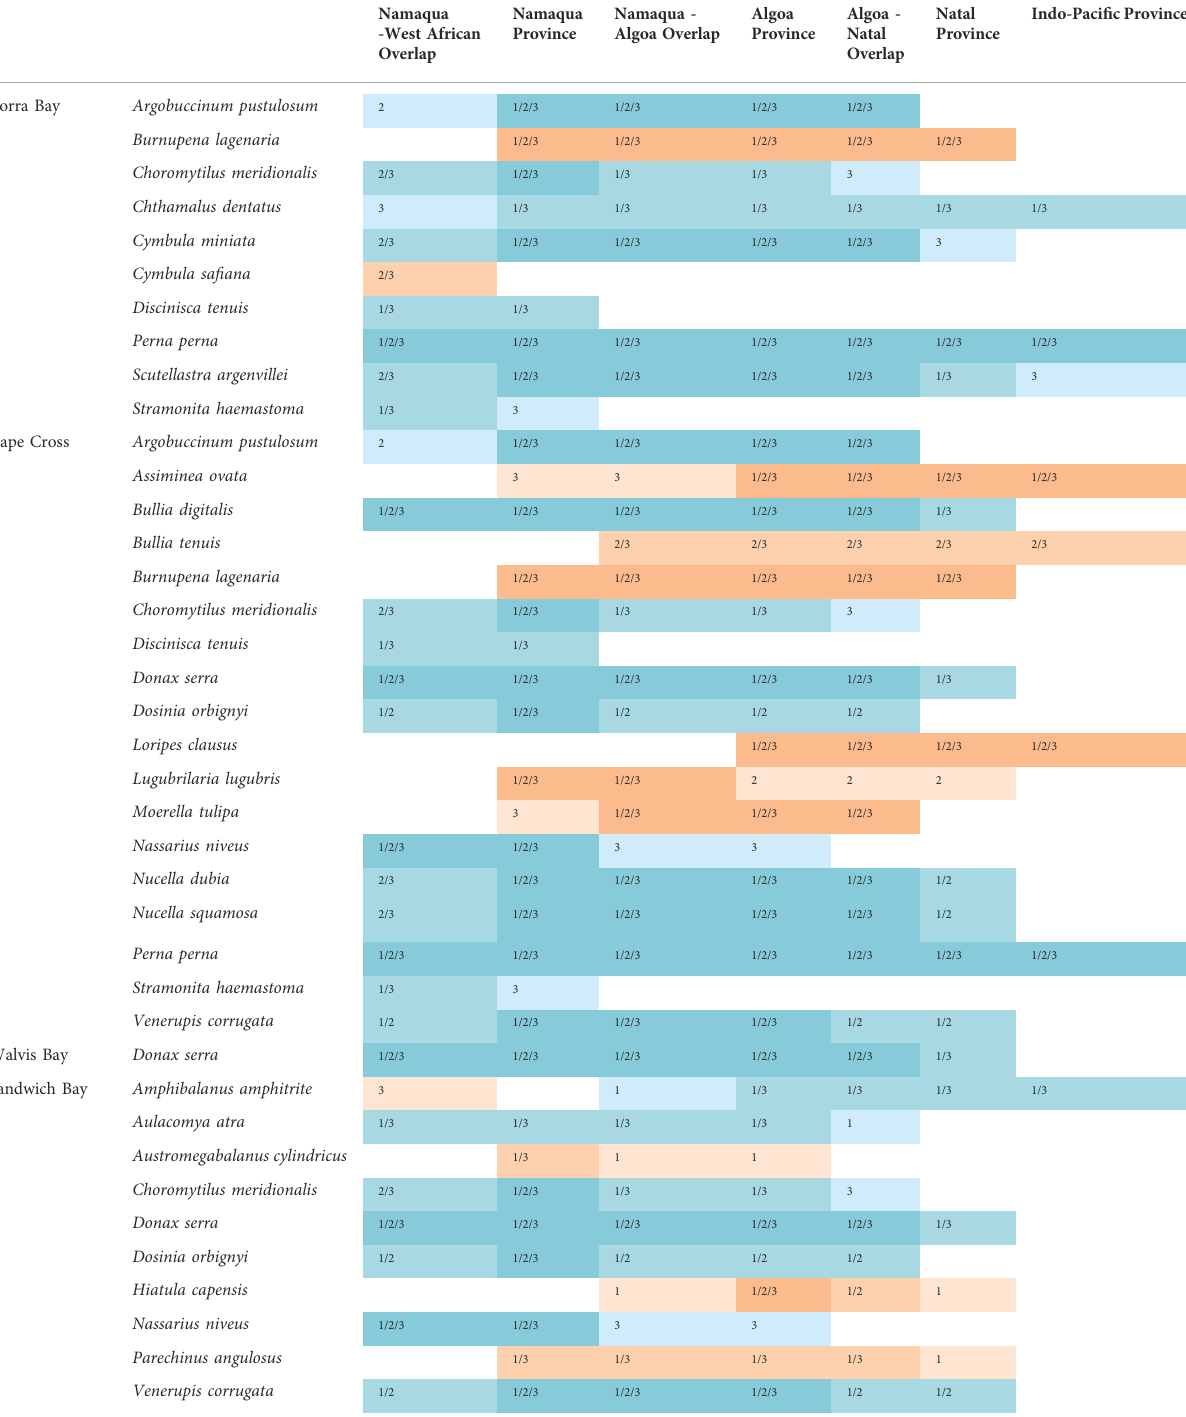
TABLE 2 List of macrobenthic faunal species from the sampled (paleo-)lagoons, beaches, and shell midden, blue: recently occurring in study area; orange: recently not occurring. Biogeographic ranges after Kilburn and Rippey (1982), Branch et al. (1994), World Register of Marine Species (WoRMS, 2022) and Ocean Biodiversity Information System (OBIS,